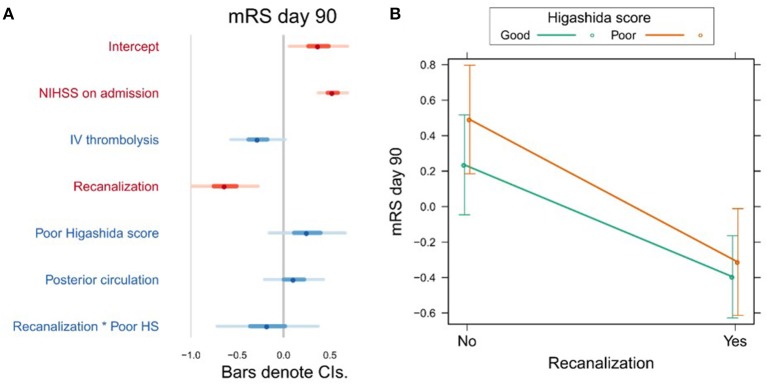
(A) Association between several variables and clinical outcome (mRS day 90). The dots indicate the beta coefficients derived from a robust multiple linear regression. Bars indicate the 95% confidence intervals (CI) of the estimates. Independent variables shown in red have statistically significant coefficients (p < 0.05). (B) Plot showing the predicted mRS day 90 values for recanalizers and non-recanalizers with good and poor Higashida scores. The plot shows that vessel recanalization is associated with lower mRS at day 90, but there is no significant association between Higashida score and mRS at day 90. In addition, the association between recanalization and mRS at day 90 is similar across patients, whether or not they have good collateral flow.